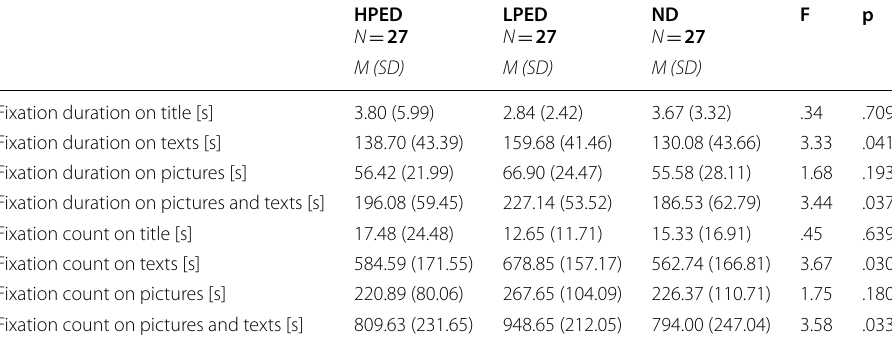
Table 2 Means and standard deviations of eye fixation duration and eye fixation count on AOIs for the three